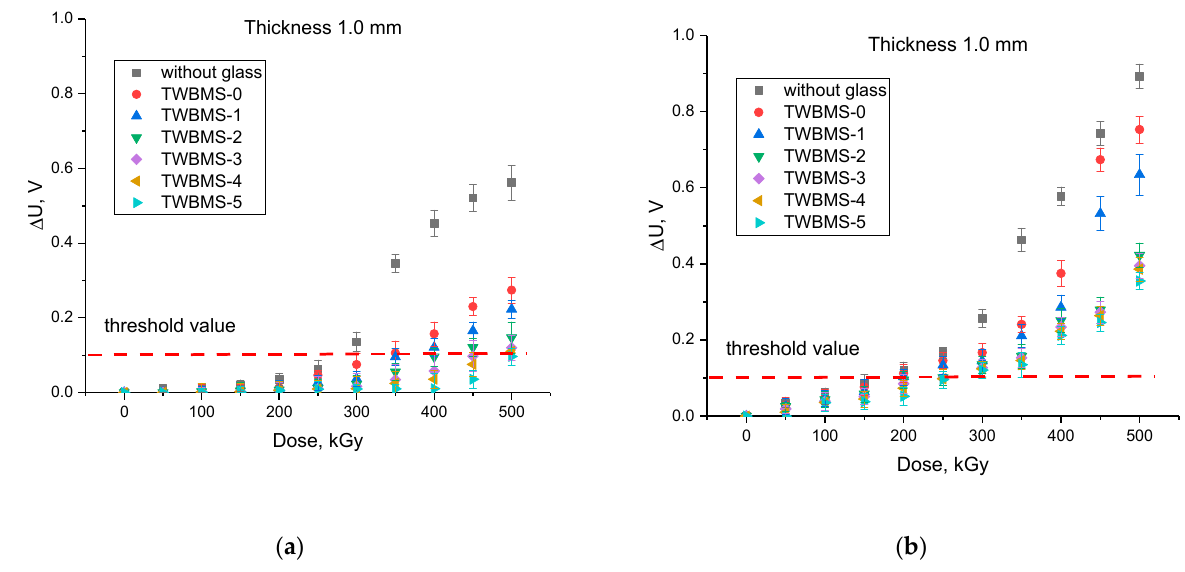
Figure 7. The results of changing the Δ U value depending on the radiation dose when shielding various types of ionizing radiation: ( a ) shielding of gamma radiation; ( b ) shielding of electronic radiation (the dotted line indicates the permissible threshold value of the ∆ U value deviation, which is considered critical in assessing the preservation of the operability of microcircuits).